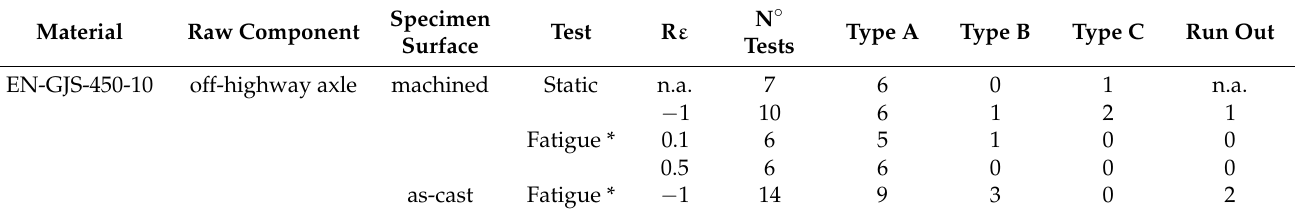
Table 6. Summary of the failure locations observed after the static and fatigue tests (see definitions in Figure 12).